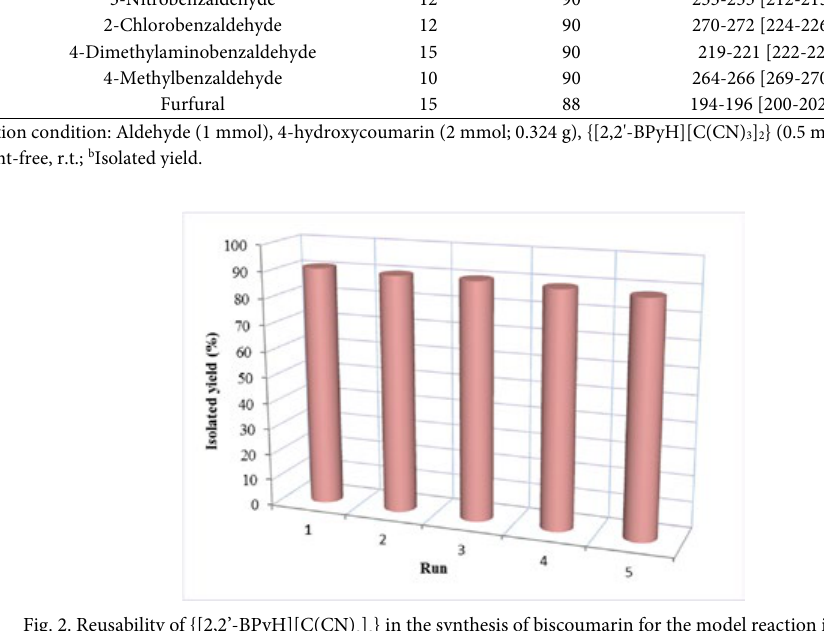
Nanochem Res 3(2): 170-177, Summer and Autumn 2018